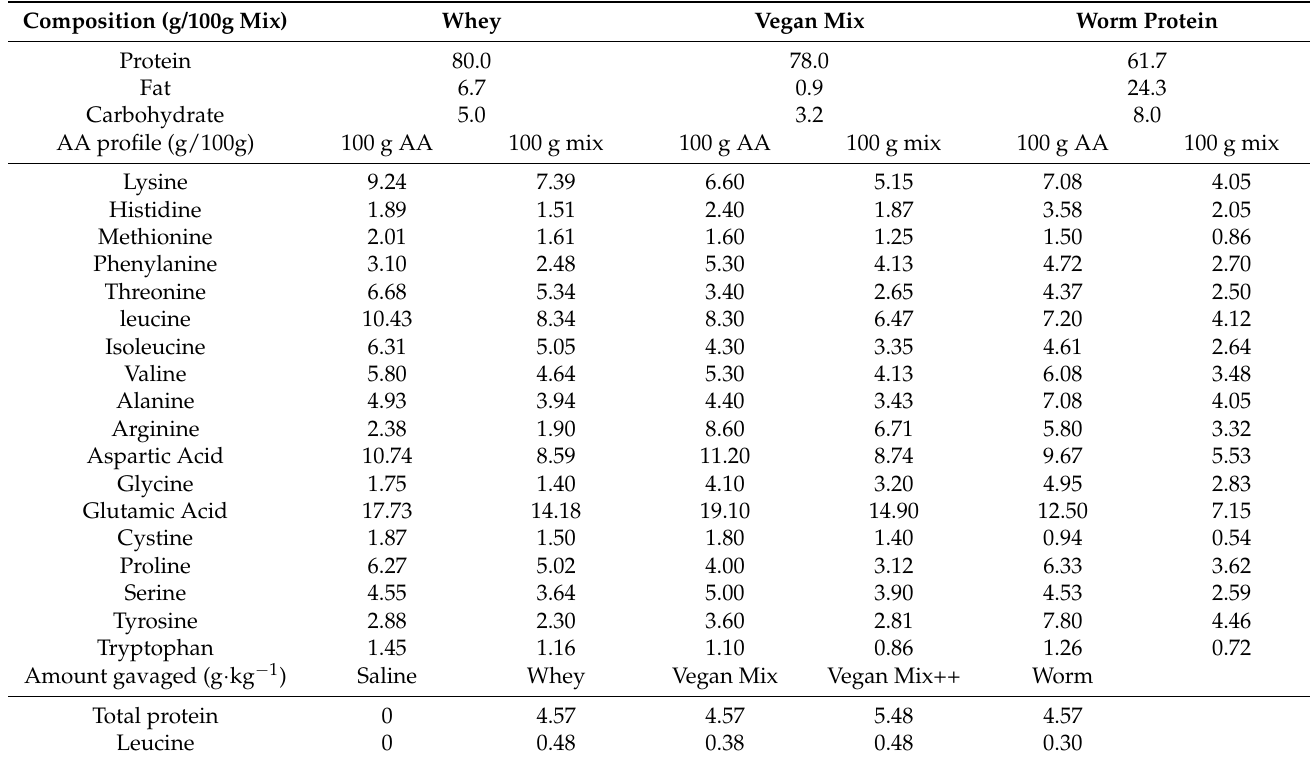
Figure 1. Experimental overview. Table 1. Amino Acid (AA) mixture specifications.